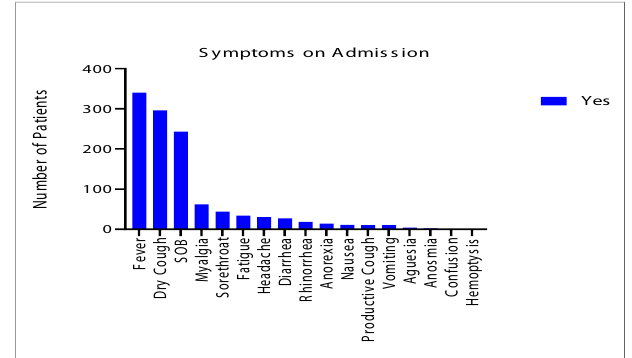
FIGURE 1 | The distribution of the 525 symptomatic COVID-19 patients on